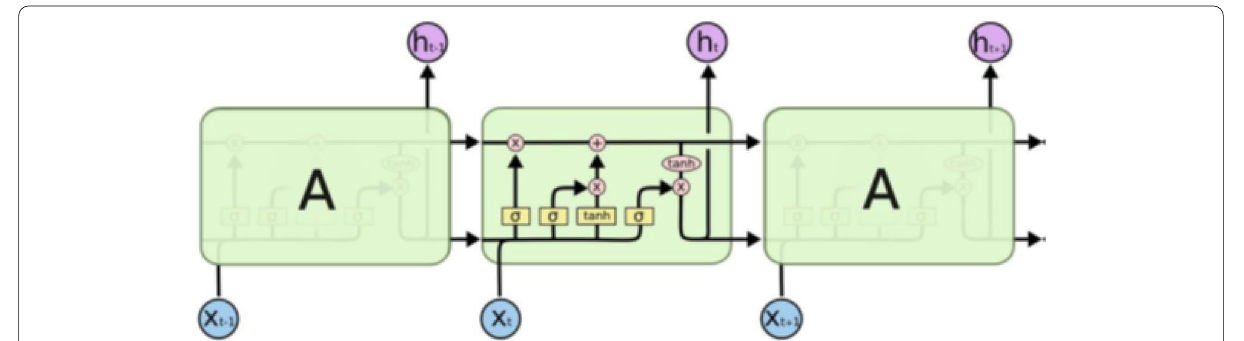
Fig. 2 LSTM cell with four interacting layers